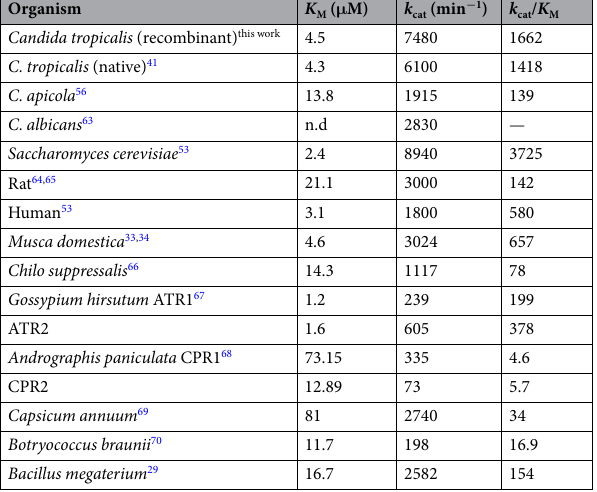
Table 1. Kinetic parameters for cytochrome c reduction by CPR from different species. n.d., not